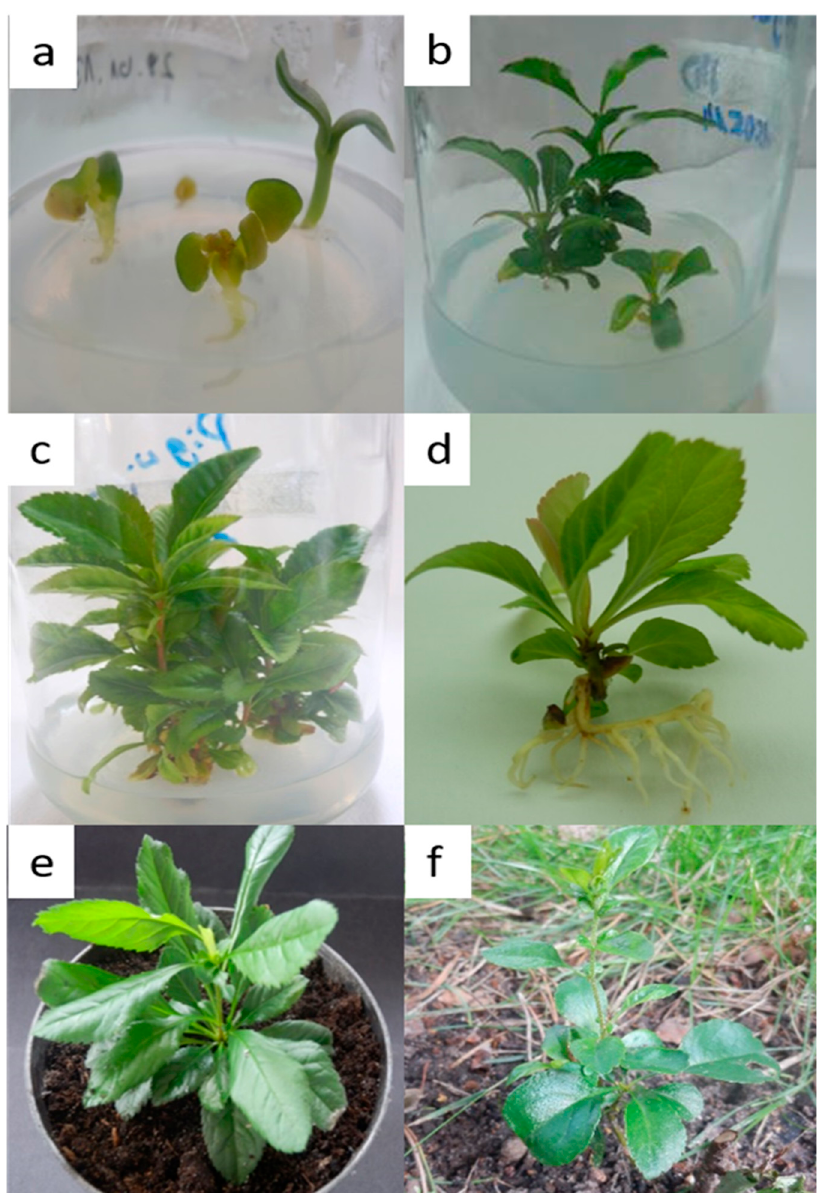
Figure 1. In vitro propagation of Chaenomeles japonica : ( a ) aseptic seedlings; ( b ) shoot tip explants; ( c ) in vitro-multiply shoots; ( d ) in vitro-rooted shoots; ( e ) hardened plantlets; and, ( f ) plant transferred to an experimental plot.